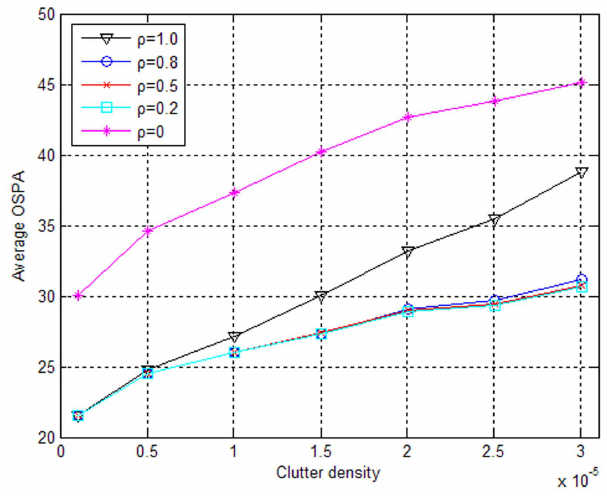
Figure 6. Performance comparison in combination with RF when r e 5 10(MHz).